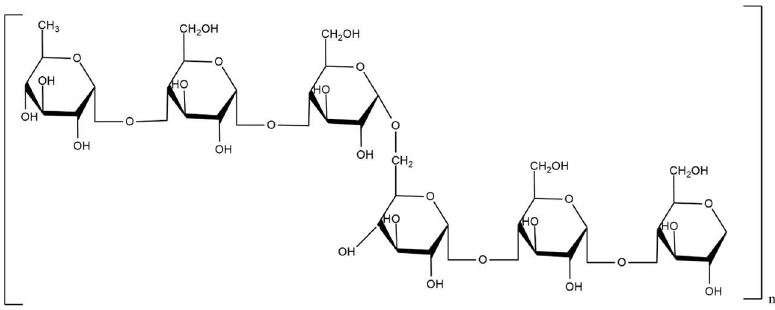
Figure 1. The chemical structure of